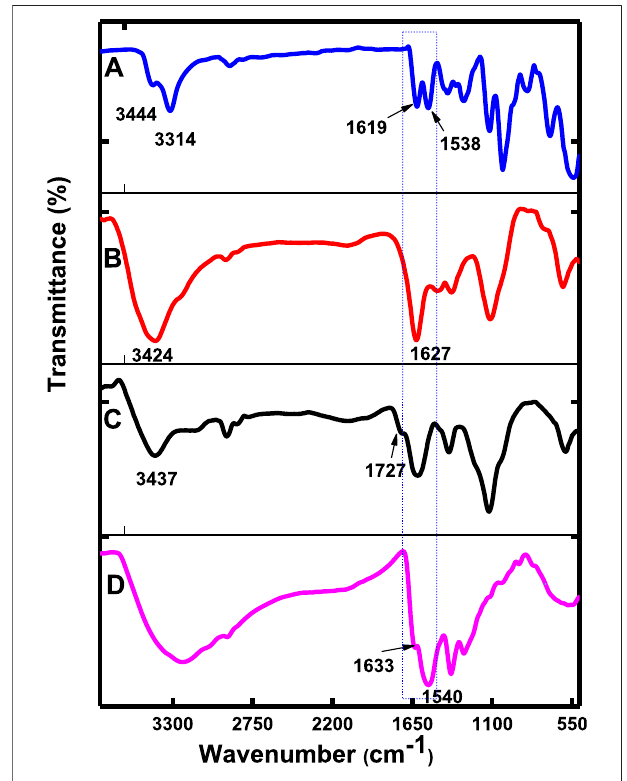
FIGURE 1 | FT-IR spectra of CoTAPc (A) , CoTAPc-GONS (B) , GONS alone (C) , and poly-CoTCPc-CoTAPc-GONS (D)